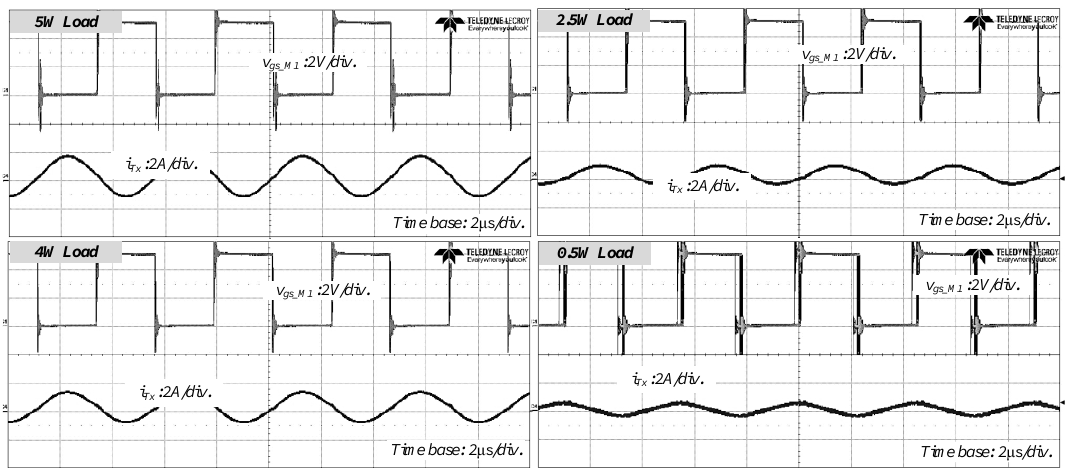
Figure 15. Experimental waveforms in the over coupling condition with the LLC resonance operation.